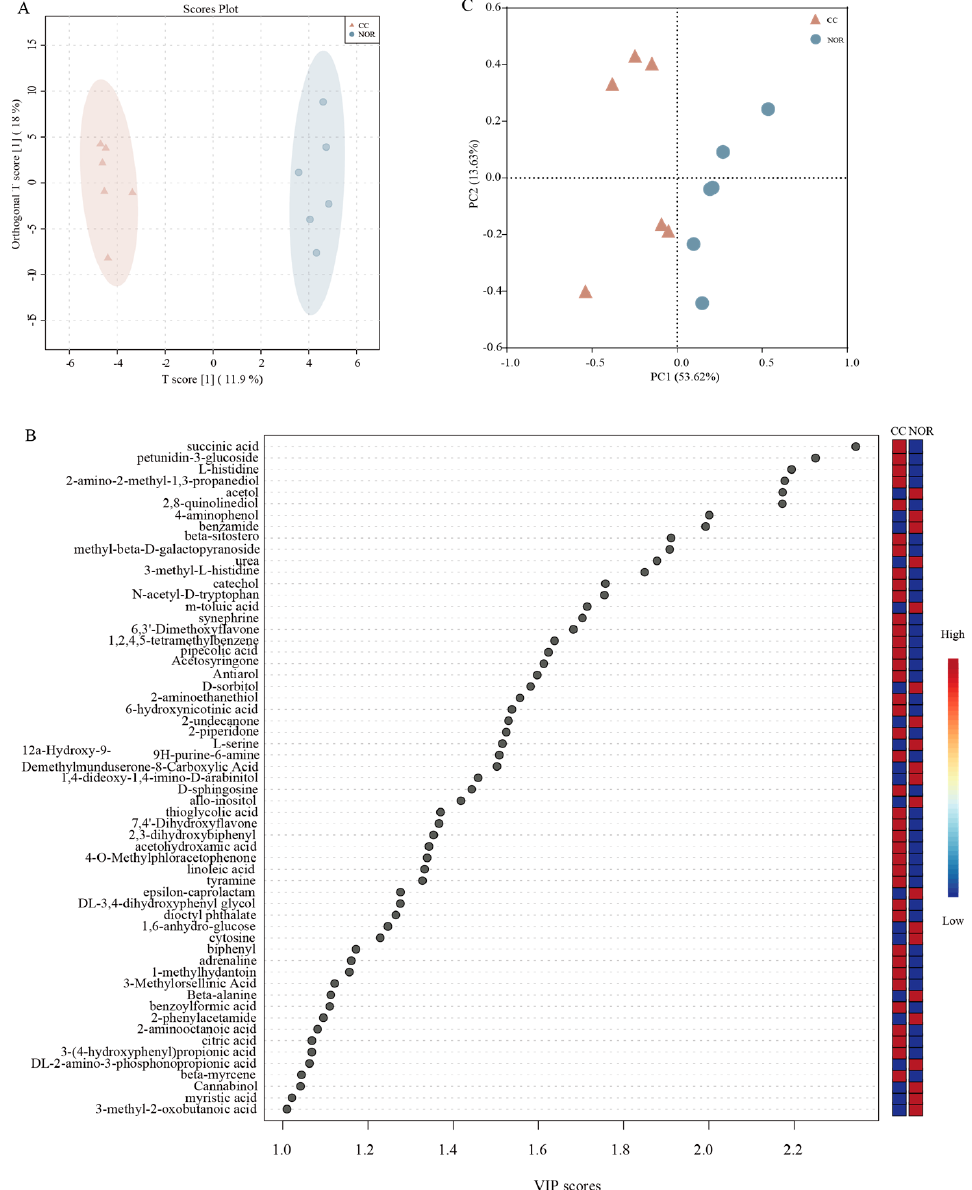
Figure 5. Metabolites in rhizosphere soil. ( A ): OPLS–DA scores plot of metabolites in soil between CC and NOR; ( B ): variable influence on projection (VIP) of compounds; ( C ): dimension reduction of important metabolites. The PCoA based on the Rho distance revealed distinct differences in metabolites when VIP >